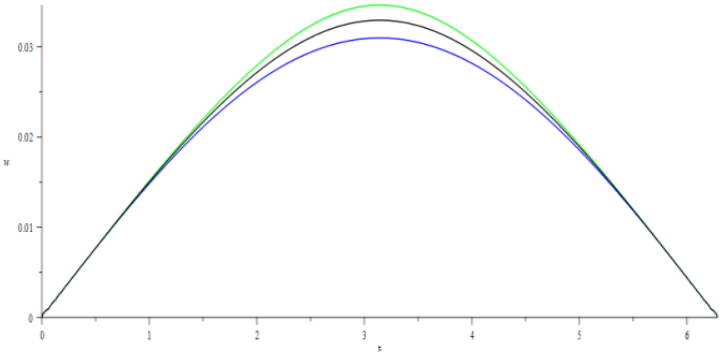
Figure 8. Influence of the polydispersity of a phonon crystal on the dispersion relations of the dependence of the dimensionless frequency on the wavenumber in the 0th passband, for a water concentration in the air equal to 0.5 (k = 0.5). Black color: big drop + big bubble + a small drop + a small bubble with dimensions 0.4 + 0.4 + 0.1 + 0.1 according to the formula “BBmm”, the graph of dispersion relations. Green color: big drop + medium bubble + a small drop + medium bubble, according to the Bsms formula with dimensions 0.4 + 0.25 +0.1+ 0.25, graph of dispersion relations. Blue color: this is a monodisperse phonon crystal with a concentration of 0.5 water and 0.5 air.